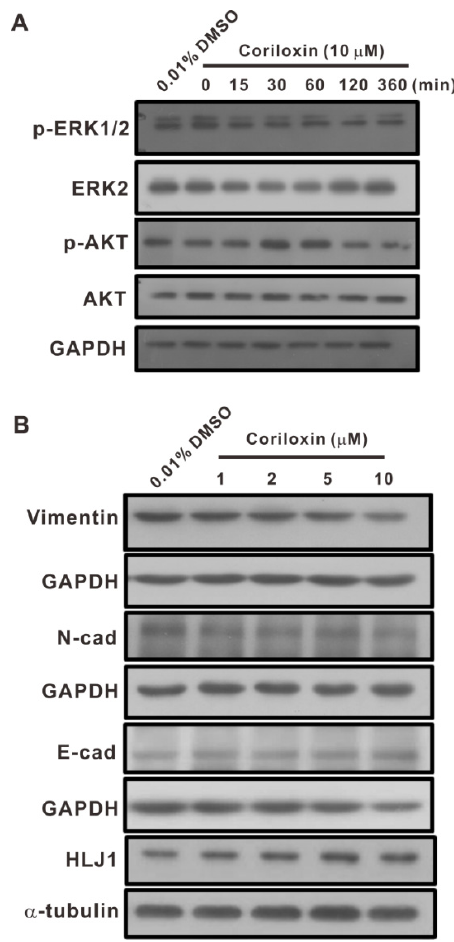
Figure 5. Effects of coriloxin treatment on ERK/AKT and the expression of EMT-related proteins in CL1-5 cells, as determined through Western blot analysis. ( A ) Effects of coriloxin on p-ERK1/2, ERK2, p-AKT, and AKT levels. Cells were treated with 10 µM coriloxin or 0.01% DMSO (solvent control), after which Western blotting revealed the protein expression levels. ( B ) Protein levels of EMT-related genes (Vimentin, N-cad, and E-cad) in CL1-5 cells subjected to 48 h coriloxin treatment (at indicated concentrations). The solvent control group was exposed to 0.01% DMSO. The loading controls were GADPH or α -tubulin. Each experiment was performed, at least, in duplicate.